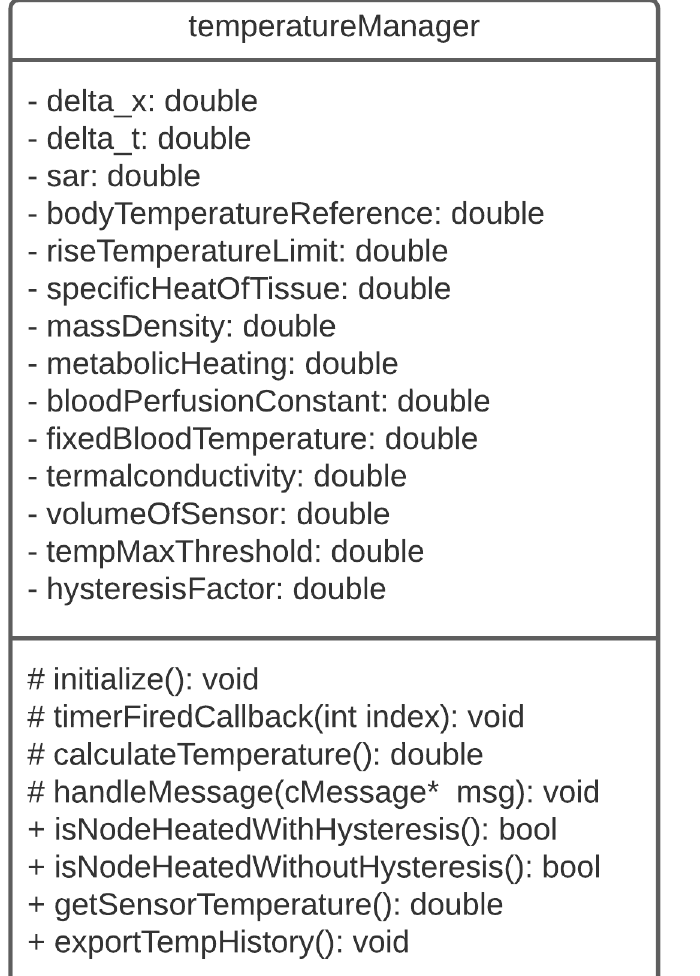
Figure 5. Class diagram of the BNS temperature model. The character “*” refers to pointer-type